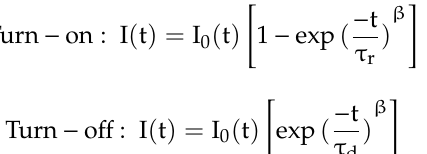
Figure 5. ( a ) Low-magnification BF TEM micrograph of FZO NR sample grown on substrate. ( b ) HR-TEM image of tip of the FZO NRs, where inset ( c ) corresponds to the SAED pattern of FZO NRs. ( d – g ) TEM elemental mapping images of as-prepared FZO NR structure for the selected region, displaying the existence of Zn (red), O (yellow), and Fe (cyan). ( h ) EDX spectra of as-synthesized FZO NR arrays.